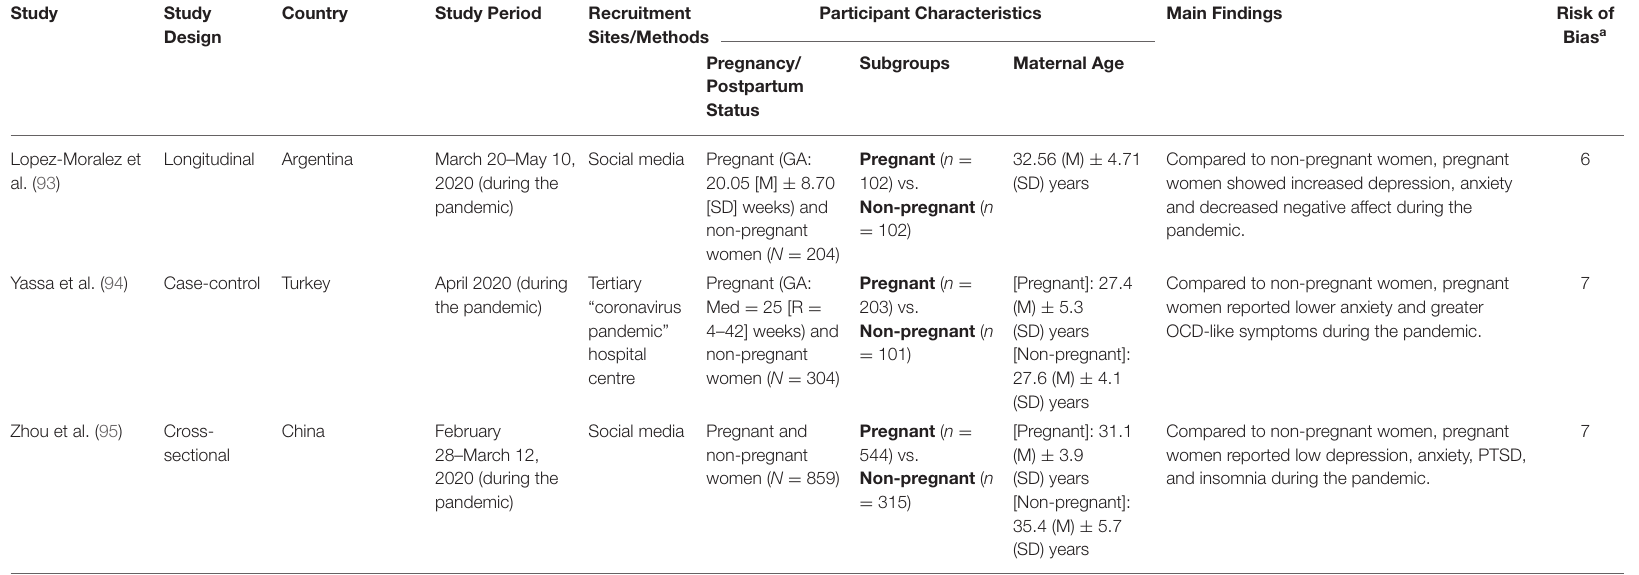
TABLE 4 | Mental health outcomes in pregnant vs. non-pregnant women during the COVID-19